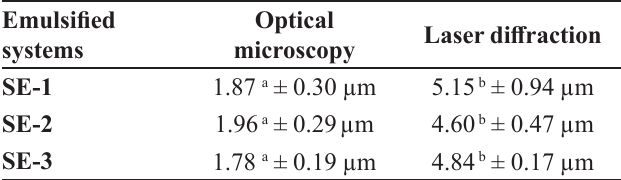
*Results presented as mean ± standard deviation. Different letters in the same column represent statistically different results, according to the ANOVA ( One-way ) and Tukey tests (p < 0.05).